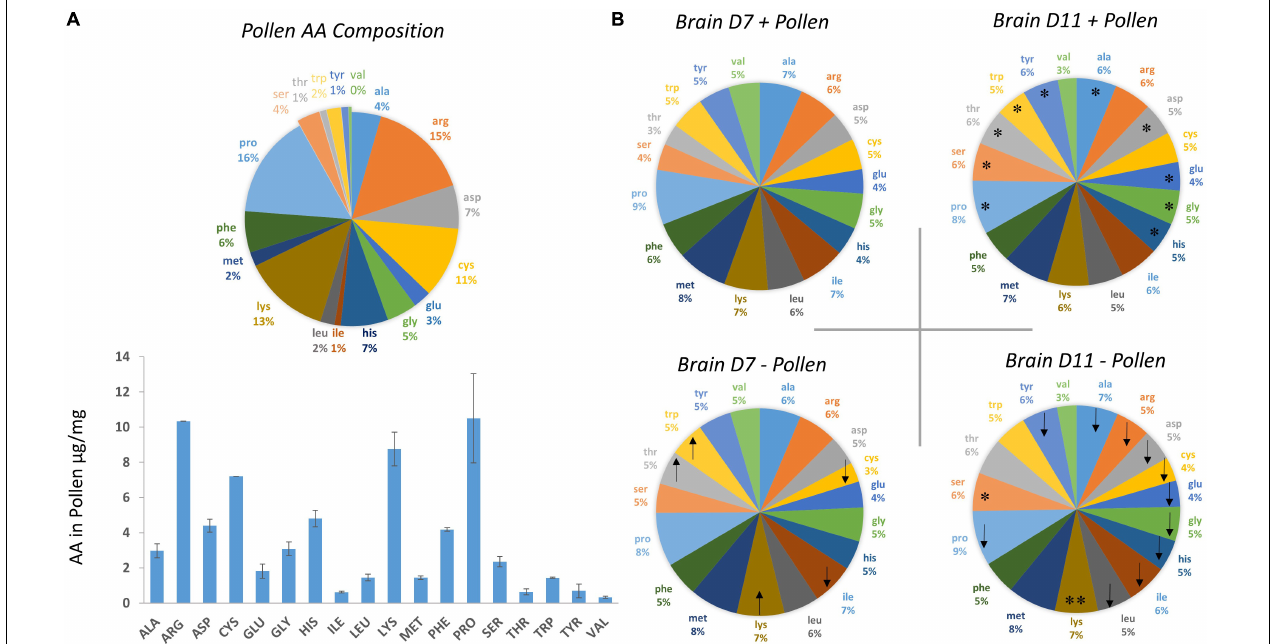
FIGURE 1 | Amino acid (AA) composition of bee-collected pollen and whole bee brains ± pollen. (A) Amino acid composition of multi-floral, bee-collected pollen fed to bees. Pollen was collected during the fall season in Tucson, Arizona during 2016. (B) Amino acid composition of whole brain homogenates were measured from bees dissected on Day 7 and Day 11 post-eclosion. Bees were fed pollen (top, + pollen) and deprived of pollen (bottom, – pollen). Arrow direction denotes an increase (up) or decrease (down) in mean amino acid levels with pollen deprivation. For example, – pollen in Day 7 bees had lower average cysteine levels compared with + pollen Day 7 bees. Asterisks denote a significant change in amino acid levels from Day 7 to Day 11 within the same feeding group (Ex. Day 7 + pollen, Day 11 + pollen). ∗ One asterisk denotes a significant increase in AA levels from Day 7 to Day 11, while ∗∗ two asterisks denotes a decrease.